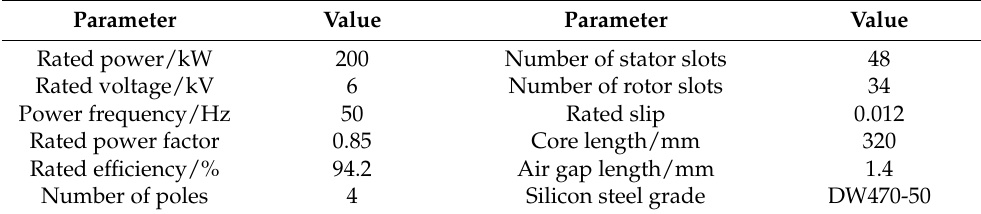
Table 1. Basic parameters of YKK3552-4 squirrel-cage